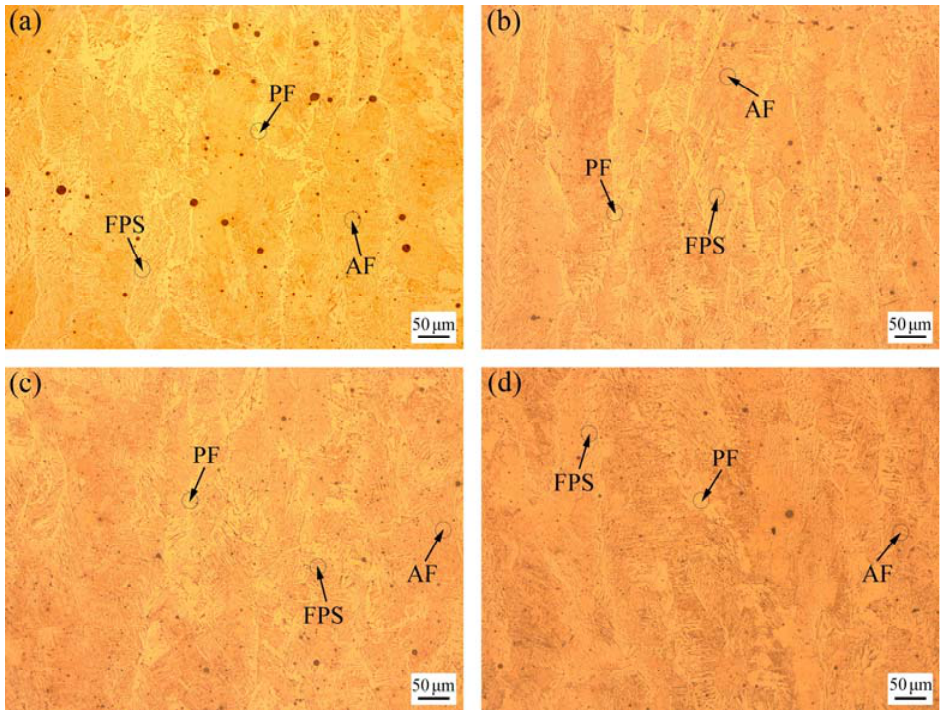
Figure 13. Microstructure of weld metal under different excitation voltages at an ultrasonic pulse frequency of 30 kHz: ( a ) 0 V; ( b ) 20 V; ( c ) 40 V; ( d ) 60 V. Table 6. Measured values of the ferrite content in the welds during the UFP ‐ UWW process.